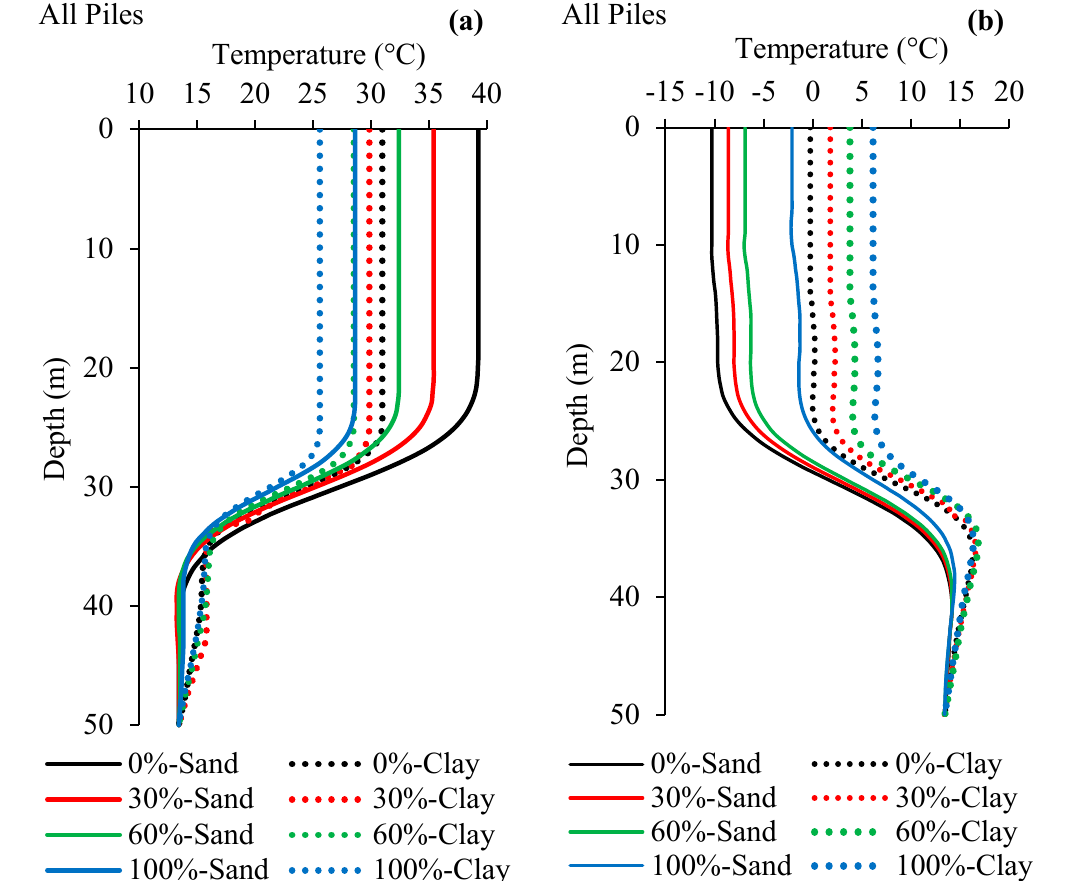
Figure 12. The results of temperature distribution with depth at the end of 10th cycle: ( a ) maximum and ( b ) minimum .